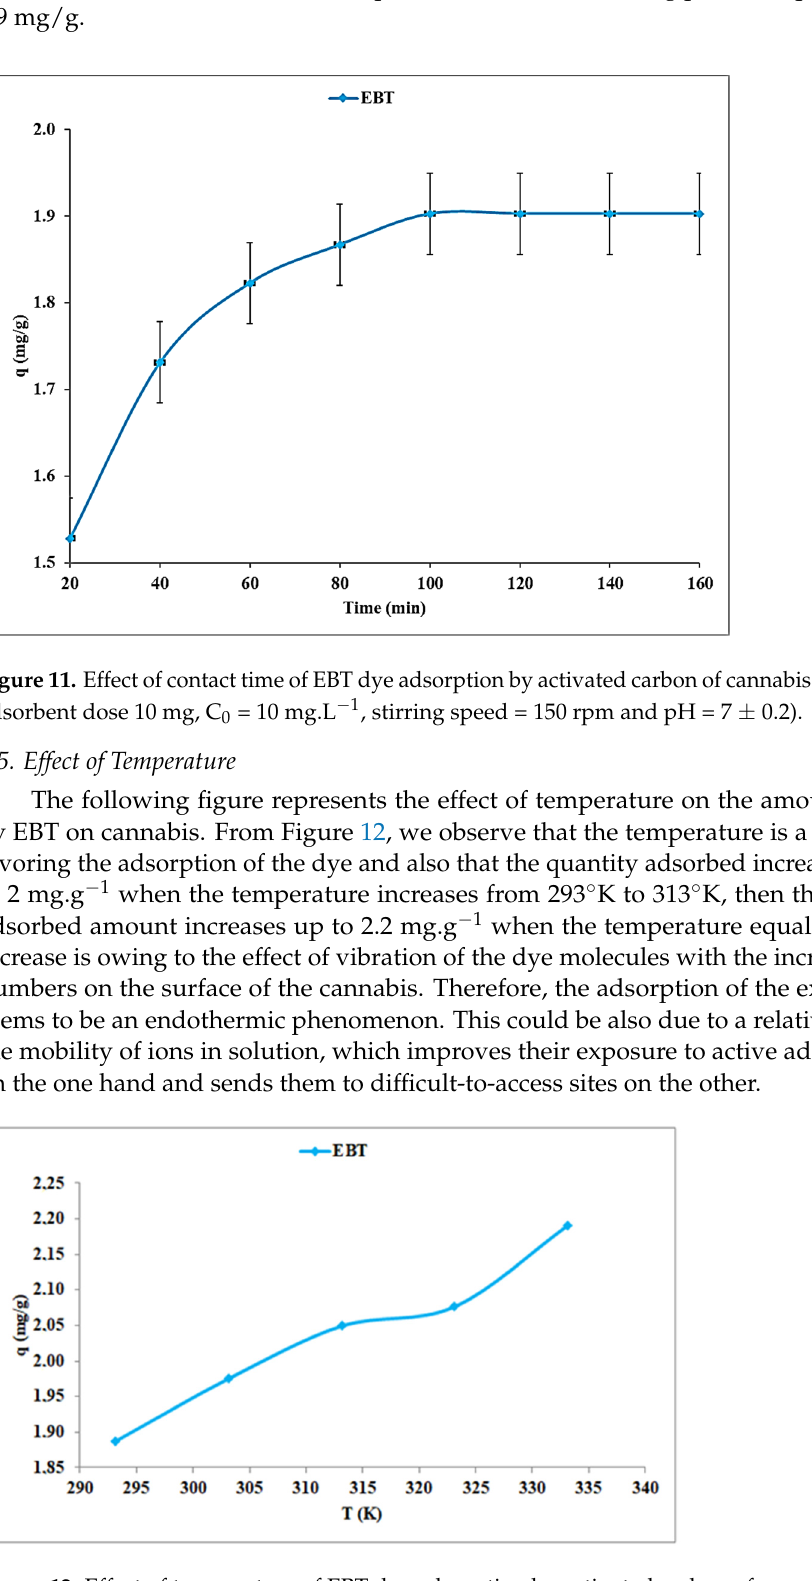
Figure 12. Effect of temperature of EBT dye adsorption by activated carbon of cannabis (adsorbent dose 10 mg, C 0 = 10 mg.L − 1 , stirring speed = 150 rpm and pH = 7 ± 0.2) .